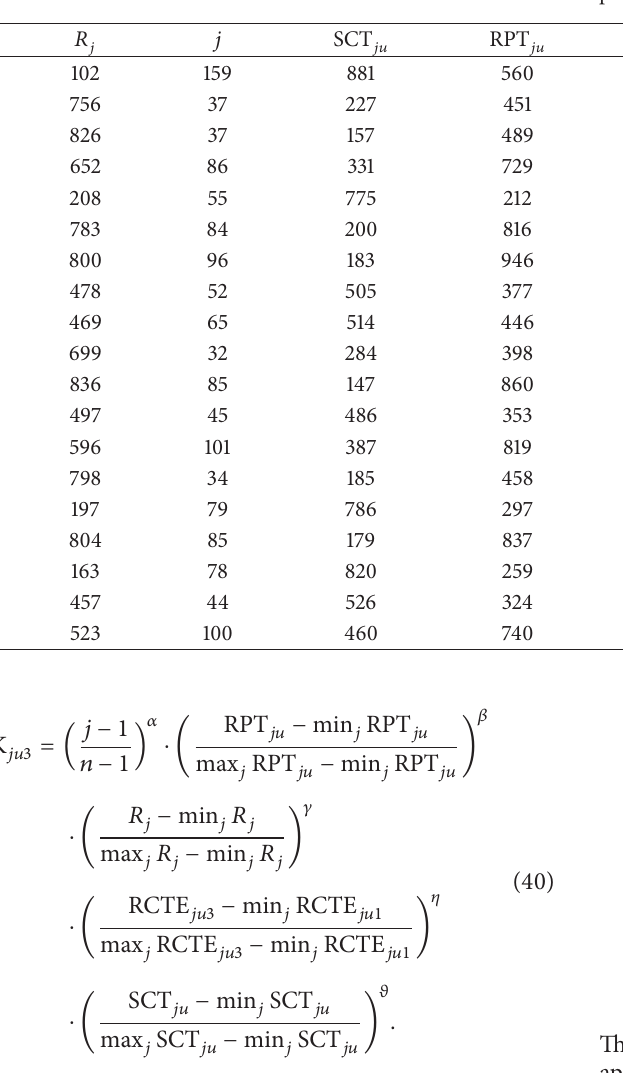
Table 5: An example ( 𝜆 =